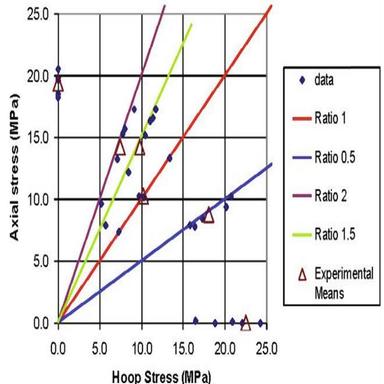
Multiaxial testing within first quadrant (combined circumferential tension and axial tension). Stress ratio indicates the ratio of applied axial stress to hoop stress.